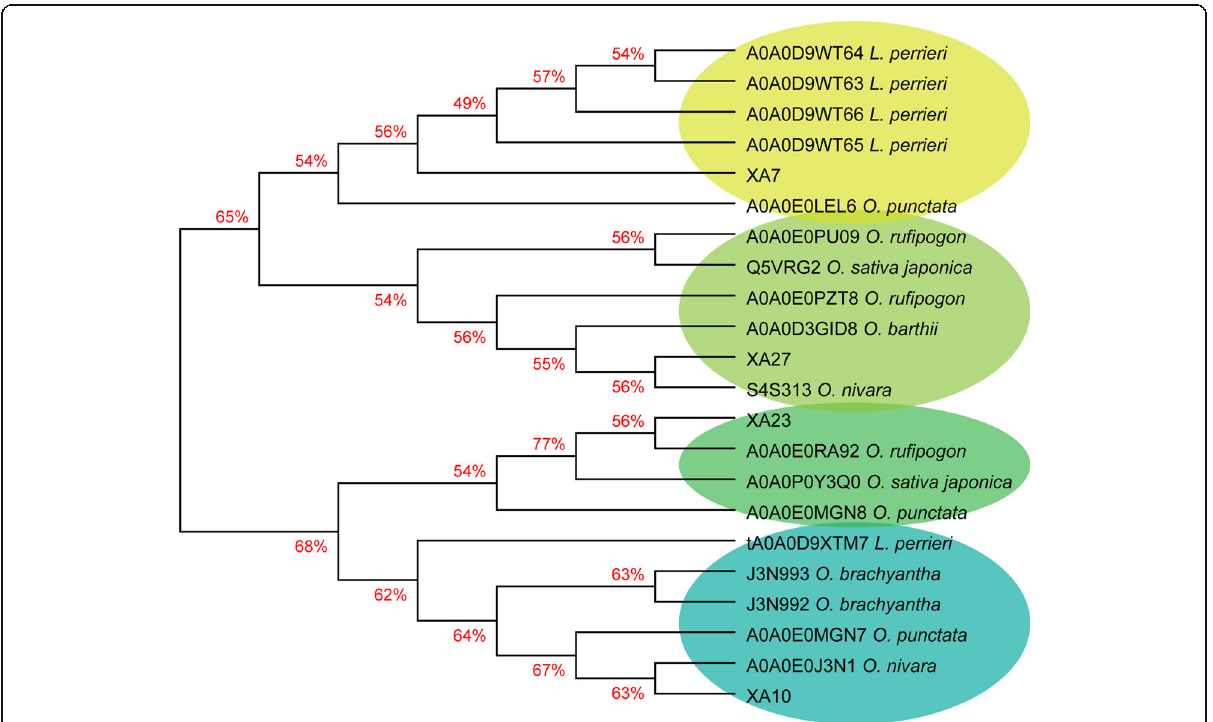
Fig. 7 Phylogenetic analysis of XA7, XA10, XA23, XA27, and their homologs. Five homologous proteins with the highest hit scores for the rice executor proteins were downloaded from the UniProt protein resource database, separately. Sequence alignment was performed using ClustalW method. The tree was constructed using the neighbor-joining